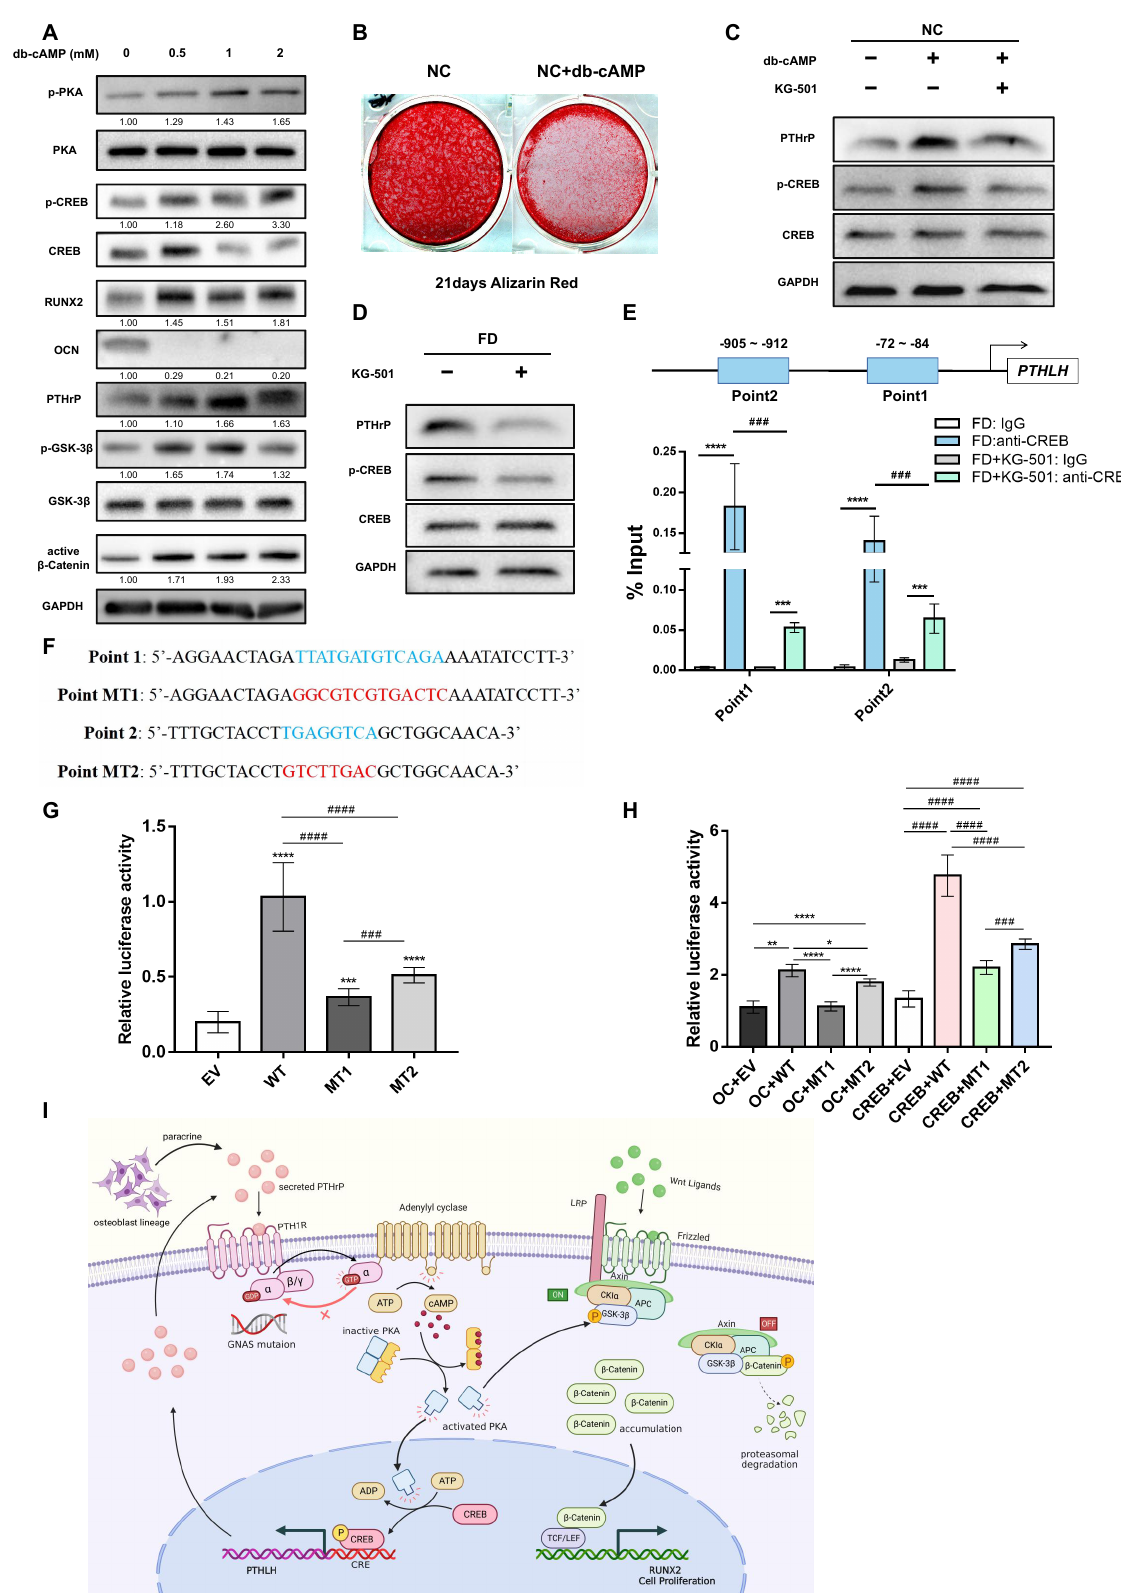
Figure 4. A positive feedback loop exists between PTHrP and the cAMP/PKA/CREB signaling pathway. ( A ): WB analysis of NC BMSCs treated with db-cAMP for 48 h at concentrations